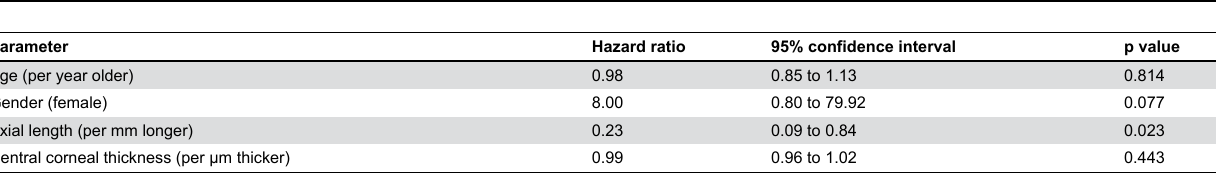
Table 2. Cox proportional hazards multivariate analysis testing the association between age, gender, axial length, central corneal thickness, and the hazards of visual field